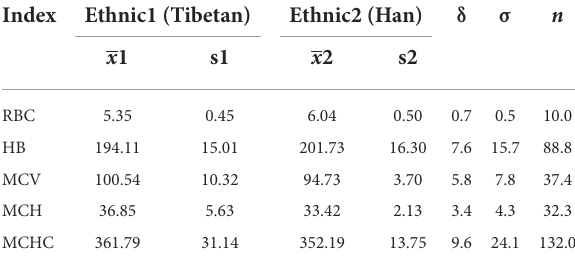
TABLE 2 Ethnic factors and minimum sample